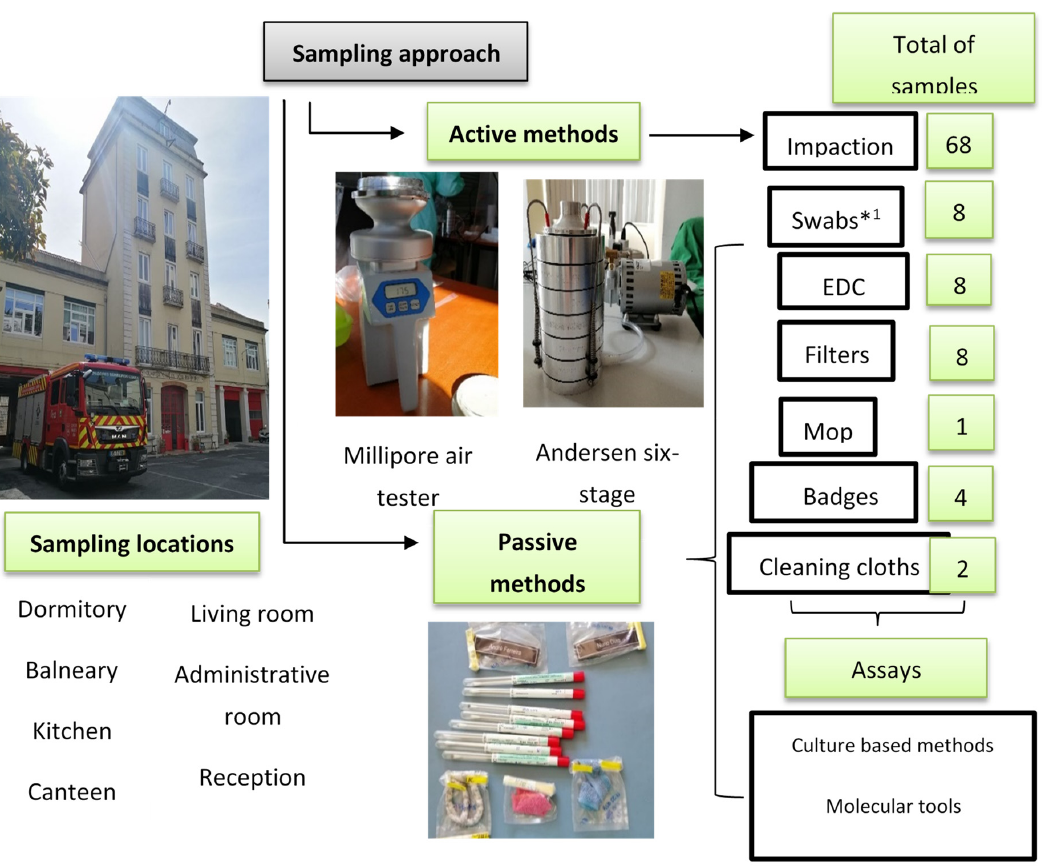
Figure 2. Sampling approach and assays applied in FFH2 assessment; EDC: Electrostatic dust collector. * 1 swabs were analysed only through culture-based methods. Indoor air was collected through active sampling methods in each selected area.